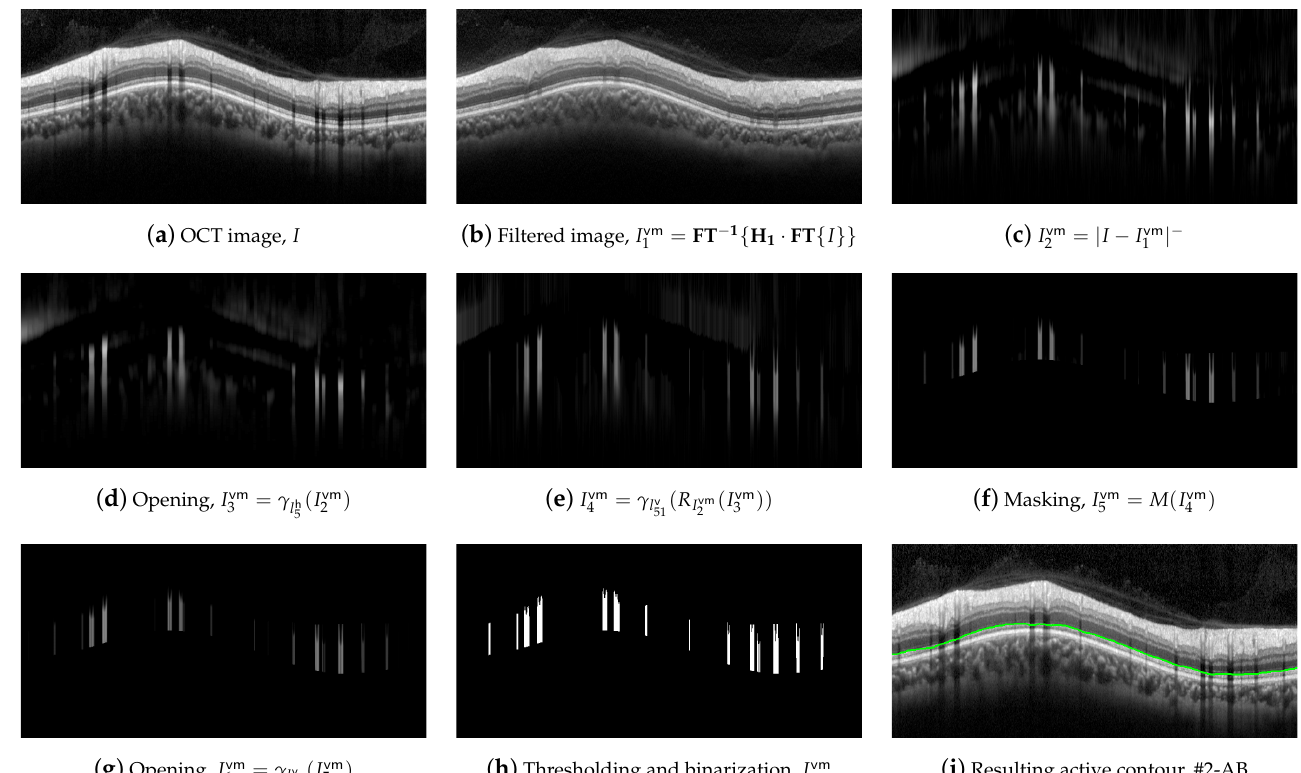
Figure 10. Computation of the blood vessel